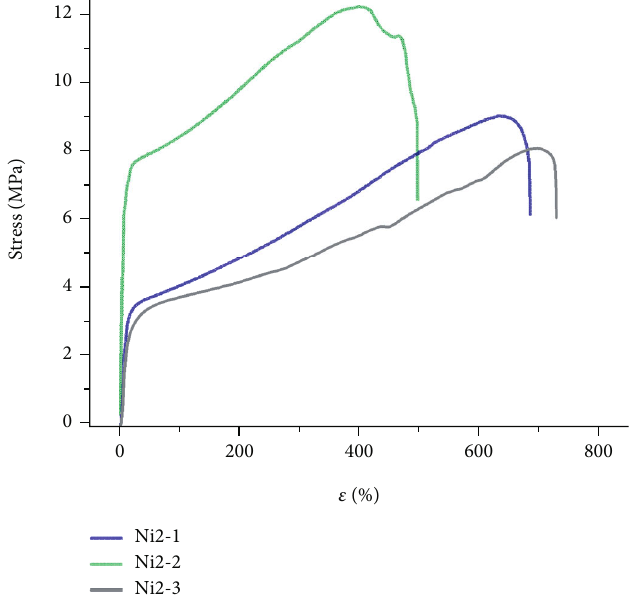
Figure 8: Stress-strain curves for Ni2